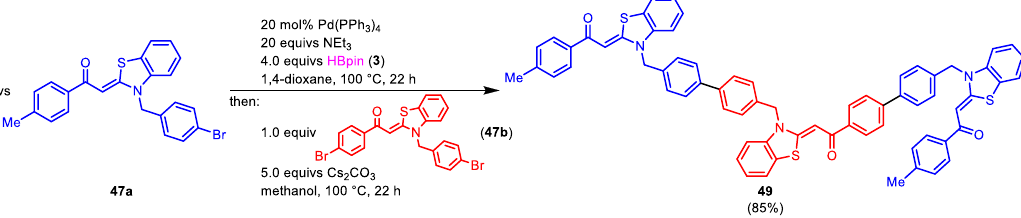
Figure 29. One-pot MBSC synthesis of ASNK trimer 49 via MBSC sequence by Biesen et al. [57].